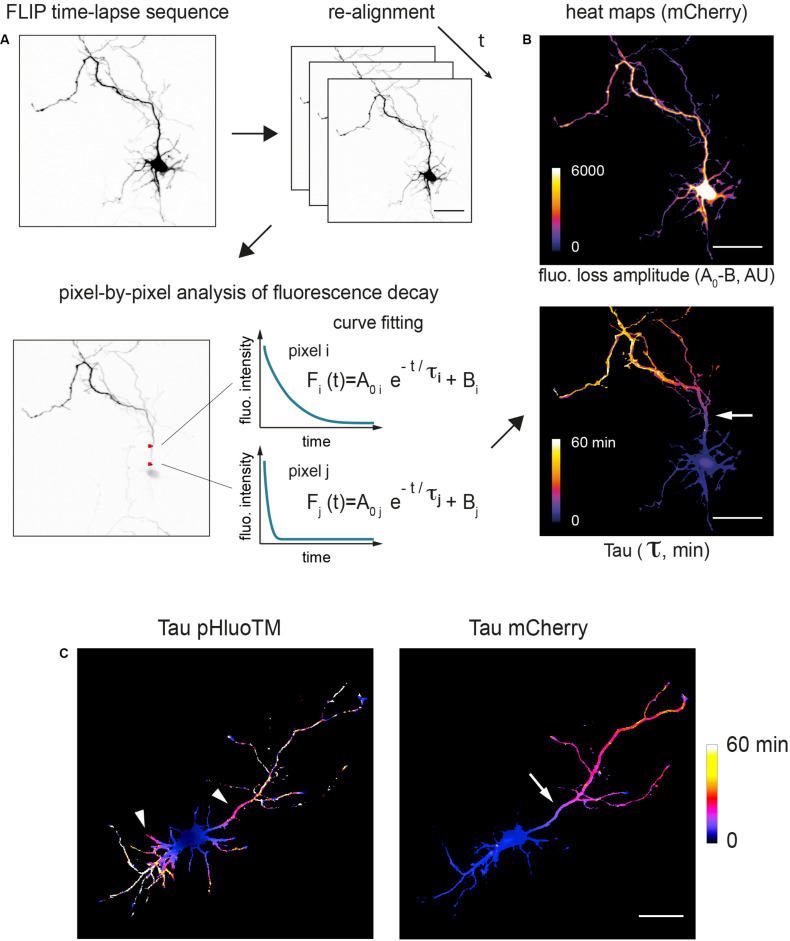
Pixel-by-pixel analysis of fluorescence decay shows localized filtering of cytoplasmic proteins at the AIS. (A) Image processing workflow. Maximum projections of z-stacks acquired at each time points are aligned using the pHluoTM channel, filtered with Gaussian functions and fluoresence decay at each pixel fitted with a mono-exponential function. Estimated decay tau and amplitude (color-coded) are then displayed as heat maps delineating the cell silhouette. (B) Shown are example maps obtained with mCherry in a DIV3 neuron. Scale bar 50 μm. In the lower panel (tau map) note the localized slowing down of mCherry (increased tau values) at the location of the presumed AIS (arrow). (C) Other examples of tau maps (color-coded, time in min) obtained for pHluoTM and mCherry at low and higher magnifications (same cell as in Figure 3A). Scale bar 50 μm. In the left hand panel (pHluoTM), note the symmetrical slowing down of pHluoTM decay in dendrites and the axon (arrowheads). In the right hand panel, note the asymmetrical slowing down of mCherry decay, markedly slower in the axon, and, as in (B), the slowing down of mCherry marking the location of presumed AIS (arrow).